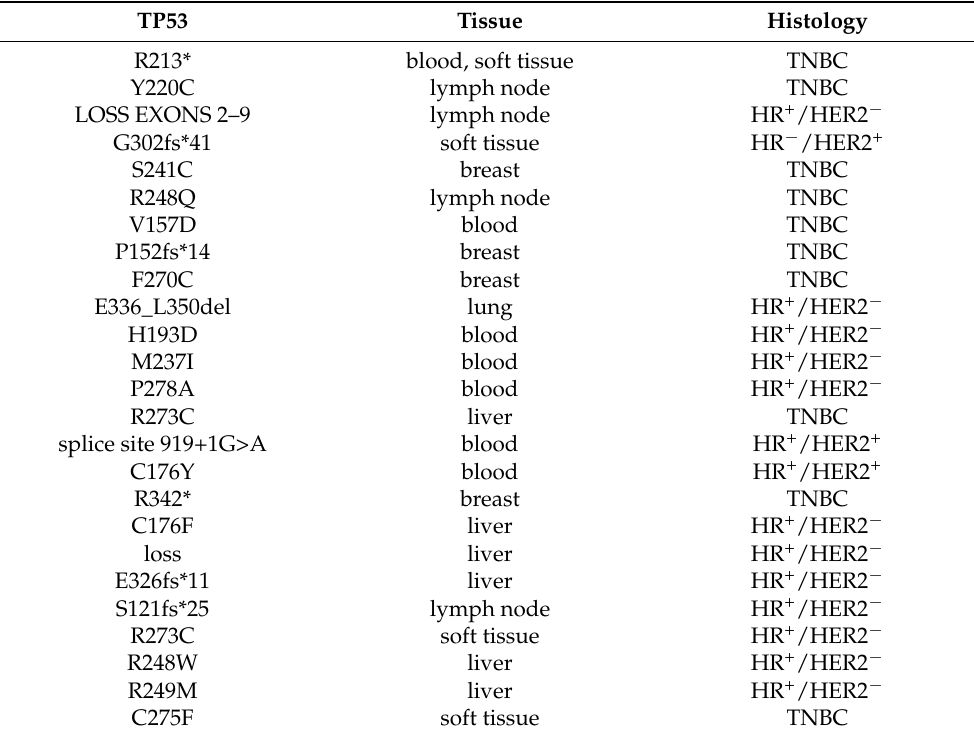
Table 2. TP53 genomic findings and clinical